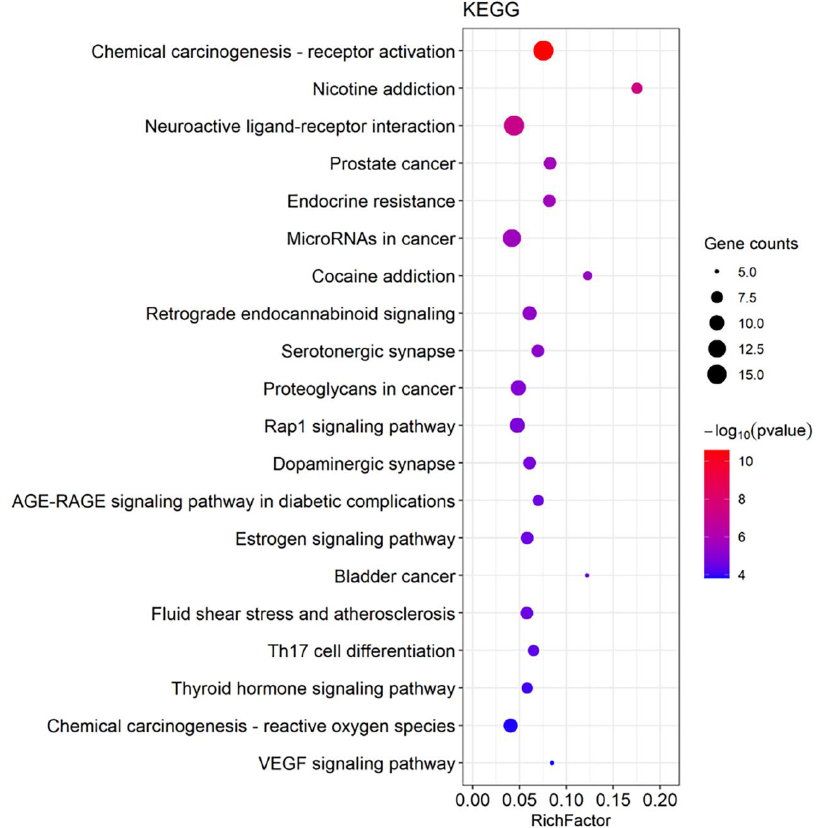
Figure 6. The top 20 dihydromyricetin (DHM)-mediated signaling pathways predicted by the Kyoto Encyclopedia of Genes and Genomes (KEGG) enrichment analysis. 3.5. Inhibition of AGE-RAGE Signaling Mediated Inflammation in CORT-Exposed Mouse Hip- pocampus We next examined one of the mapped top signaling pathways, AGE-RAGE, in the hippocampus of mice chronically treated with CORT. We found that the levels of AGE and RAGE proteins were significantly increased in the CORT-treated animals, compared to the control animals; DHM-treated animals had significantly lower levels of AGE and RAGE proteins compared to animals treated with CORT alone (Figures 7A,B and S1). Ac- tivation of the AGE-RAGE signaling pathway can lead to upregulation of proinflamma- tory cytokines [27]. Consequently, we examined the production of IL- 1β, IL - 6 and TNFα in the hippocampus of these animals by ELISA. The levels of these proinflammatory cy- tokines were markedly increased in CORT-treated mice compared to the control animals; mice co-treated with DHM had a marked decrease in the expression of these cytokines (Figure 7C) compared to those treated with CORT alone.